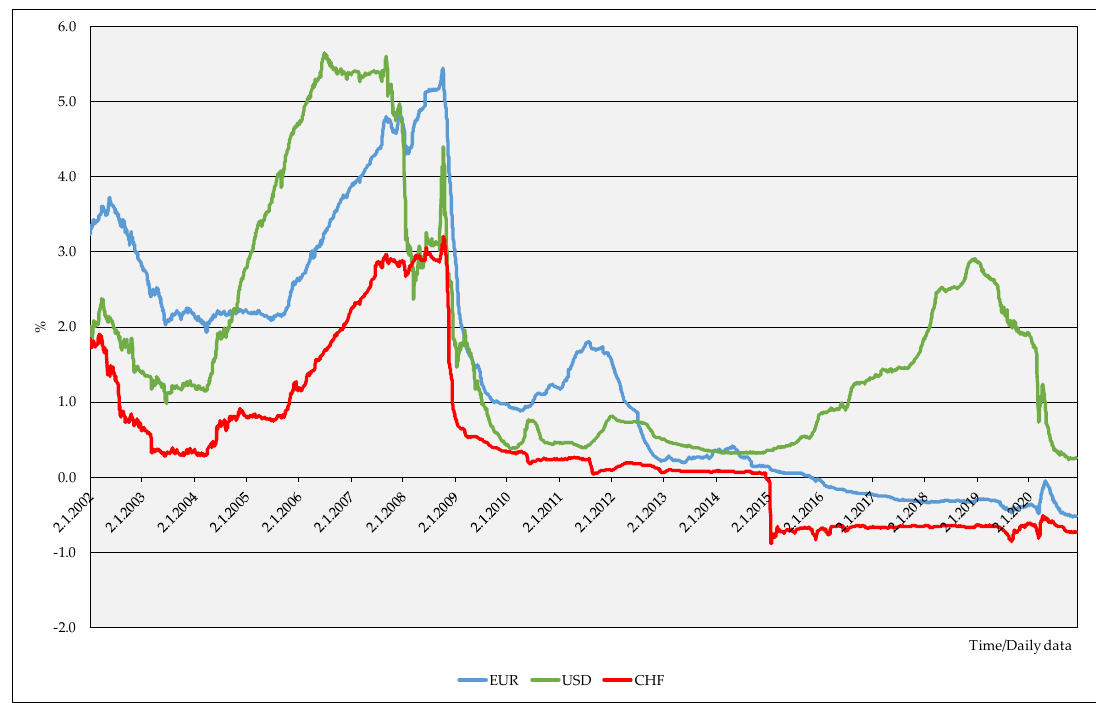
Figure 4. Six-month LIBOR, daily data for the 2 January 2002–2 December 2020 period. Source: Author’s presentation of Bloomberg data.